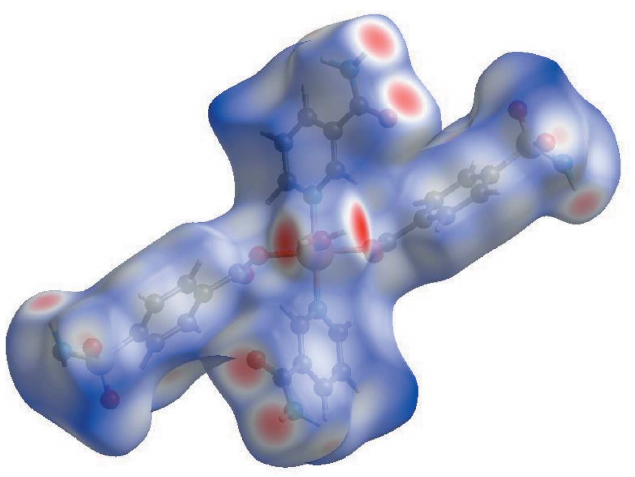
Figure 3 View of the three-dimensional Hirshfeld surface of the title complex plotted over d norm in the range (cid:3) 0.7548 to 1.5398 a.u.